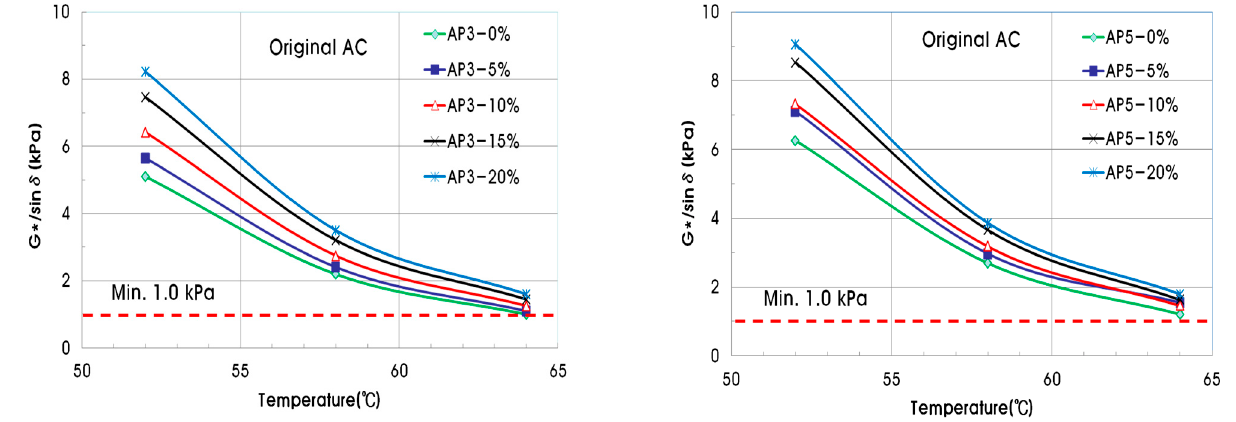
Figure 6. G*/sin δ of original asphalt binder for permanent deformation.